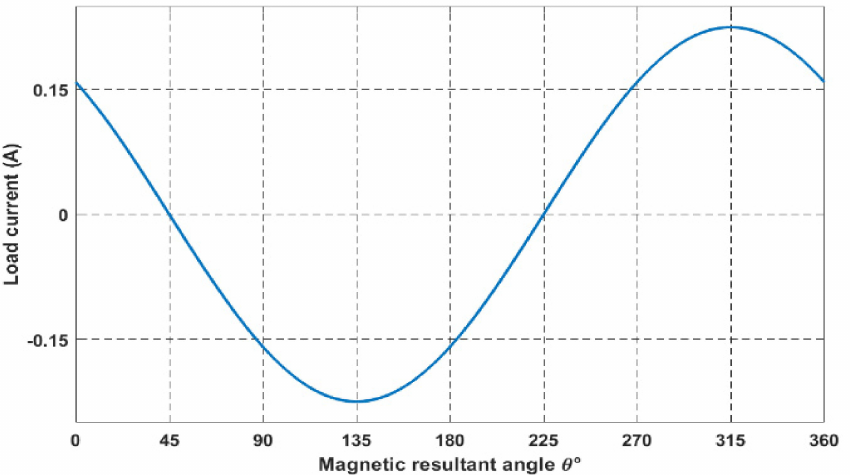
Figure 3. Load current when the magnetic field rotates around the origin for receiver placed at θ = 135 ◦ .